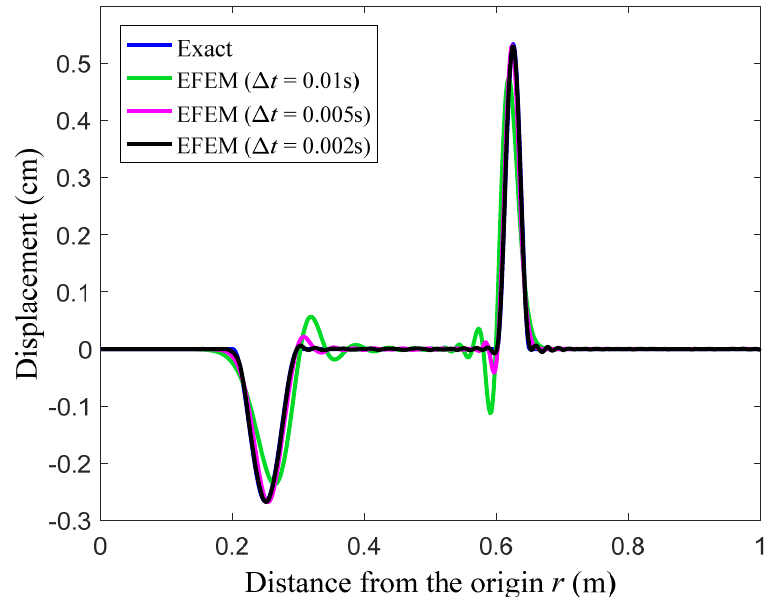
Figure 9. The displacement solutions from the present EFEM for the elastic bar.